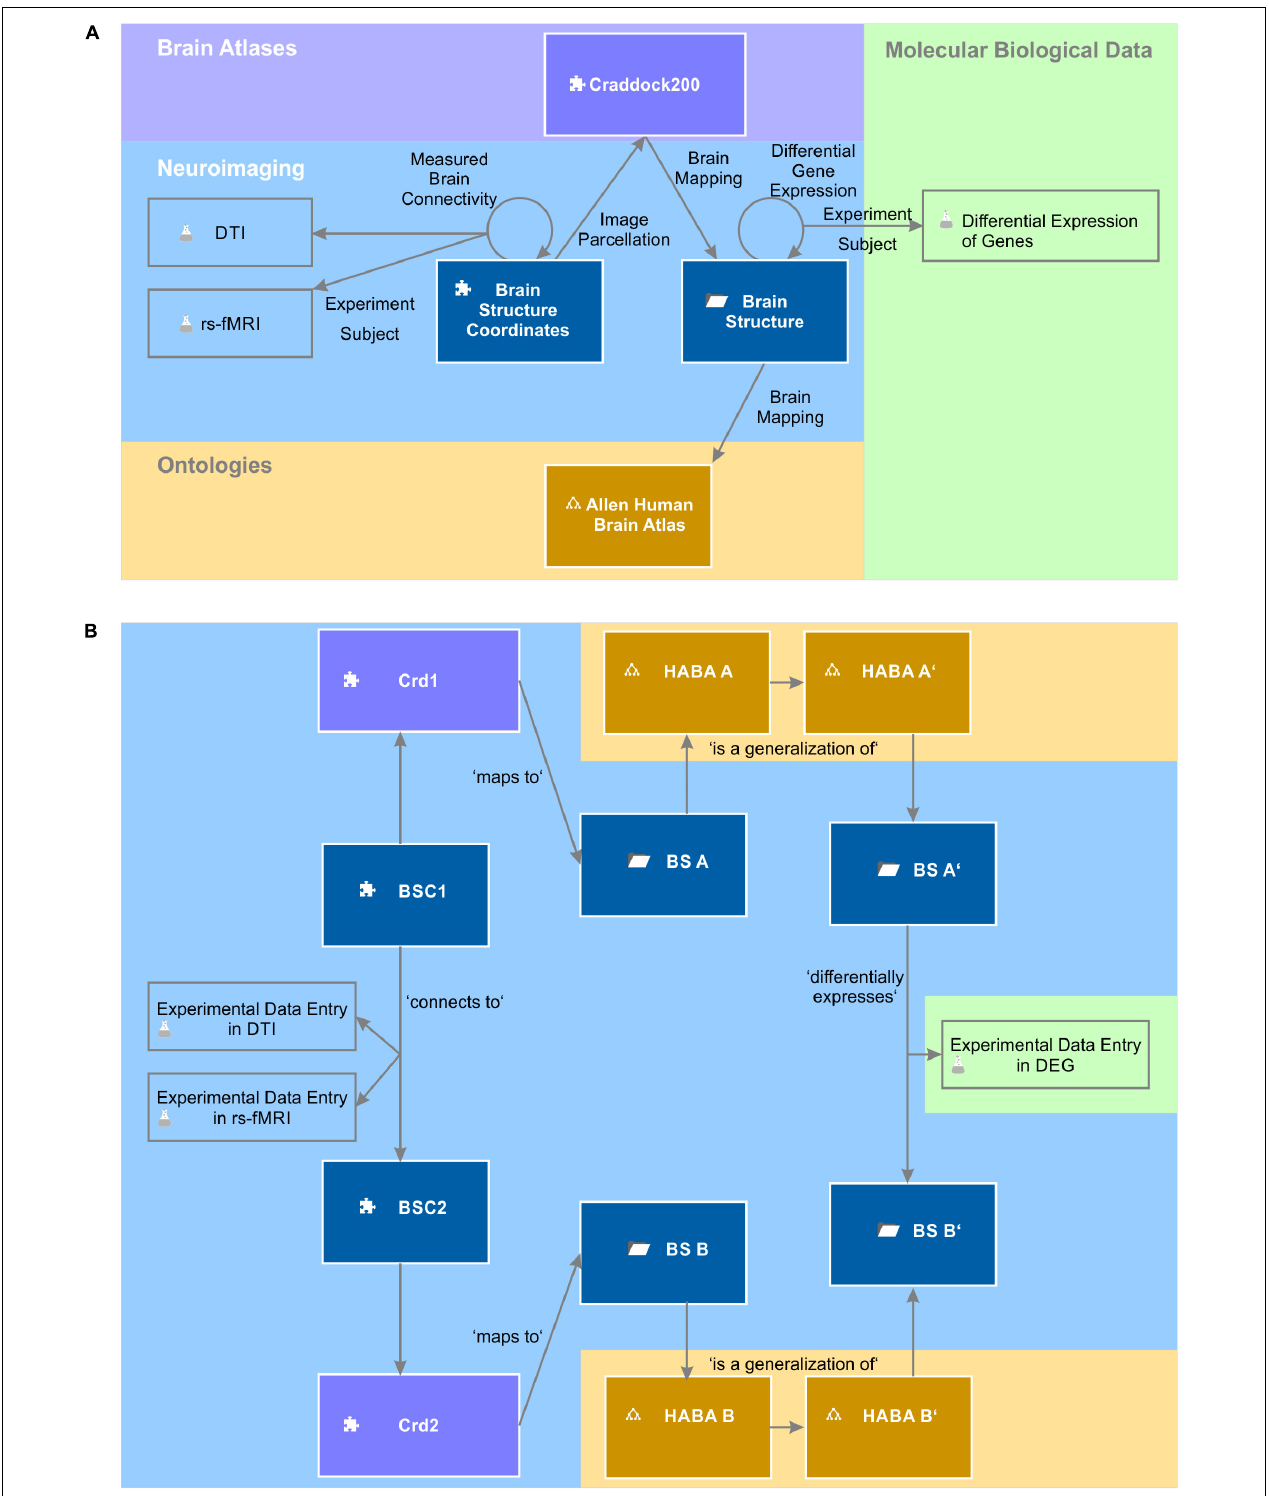
FIGURE 9 | Knowledge model and instances of semantic objects and relations. (A) The query to relate gene expression networks with brain connectivity makes use of the depicted semantic objects and relations. A query describes a defined path through the semantic network. (B) The picture depicts the instantiation of the knowledge model described in (A) . The query returns experimental data entries in a differential expression of genes (DEG) experiment, which are indirectly related to experimental data entries in DTI and rs-fMRI experiments.